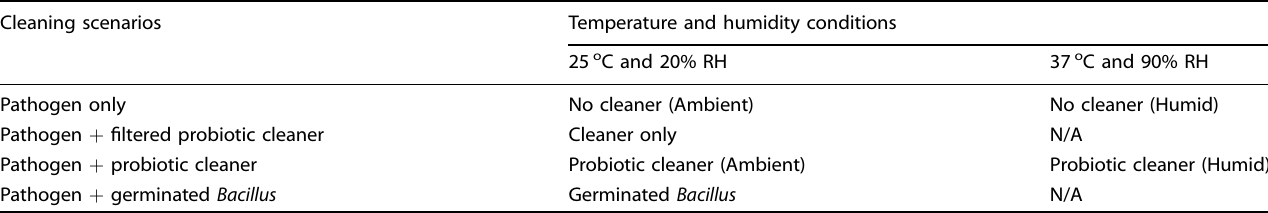
Table 1. Testing scenarios and their experimental group names for each pathogen (i.e., A. baumannii and K. pneumoniae) consisting of four cleaning conditions, and two temperature and humidity conditions.